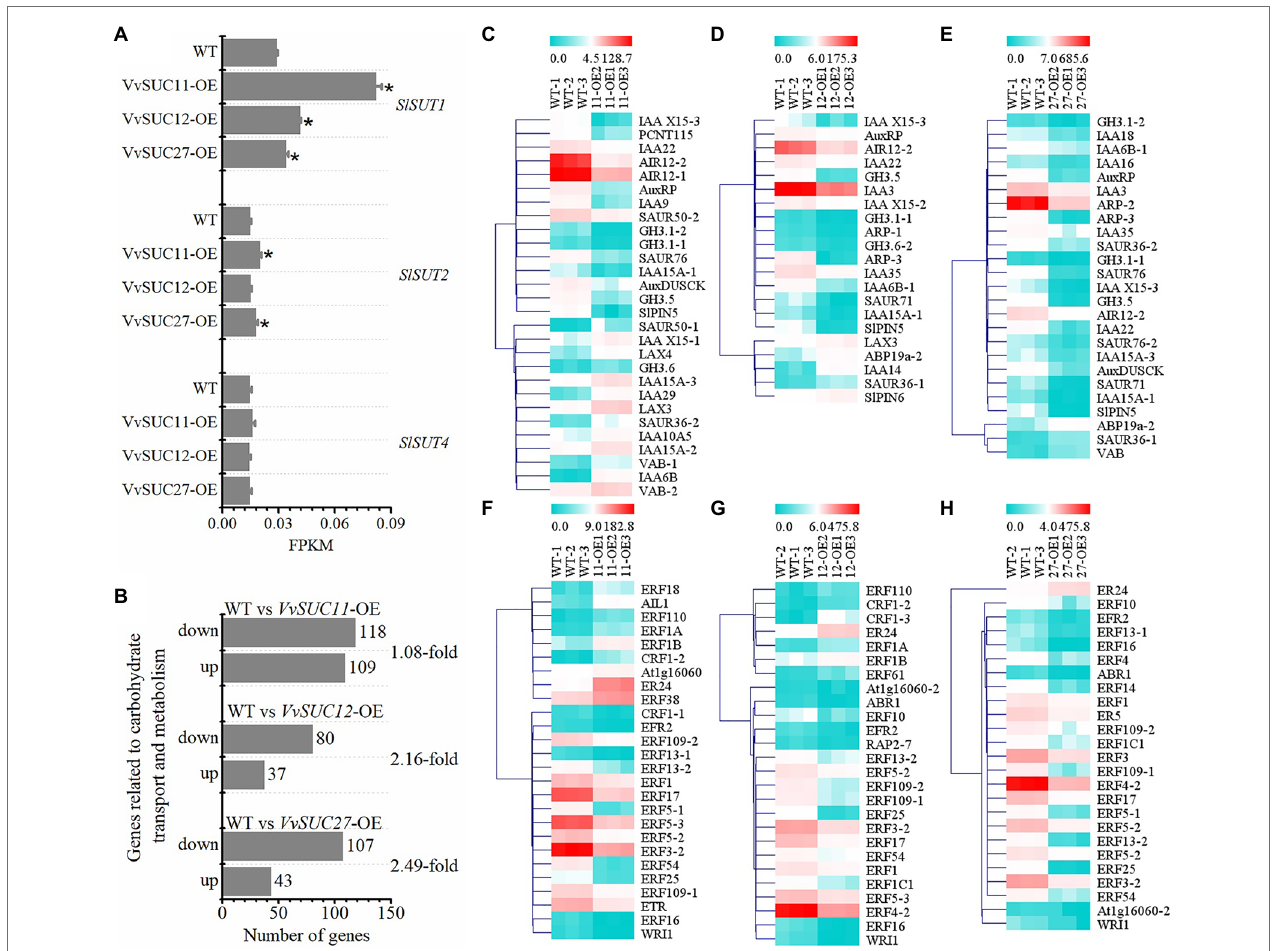
FIGURE 7 | Identification of genes related to SlSUTs , carbohydrate transport and metabolism, auxin and ethylene biosynthesis, and signaling. log2FC is short for log 2FoldChange . (A) Comparison between the WT and each VvSUC -OE line regarding FPKM of SlSUT1 , SlSUT2 , and SlSUT4 . (B) Number of upregulated and downregulated genes related to carbohydrate transport and metabolism pathway. (C–E) Heat map of genes related to auxin biosynthesis and signaling between the WT and each VvSUC -OE fruit. IAA, SAUR, or PCNT115, auxin-induced protein or auxin-responsive protein; GH, indole-3-acetic acid-amido synthetase; AIR, auxin- induced in root culture protein; ARP, auxin-repressed 12.5 kDa protein-like; AuxRP, auxin-regulated protein; SlPIN, auxin efflux facilitator; VAB, auxin canalization; ABP, auxin-binding protein; AuxDUSCK, auxin-regulated dual-specificity cytosolic kinase; LAX, auxin influx carrier (AUX1 LAX family). (F–H) Heat map of genes related to ethylene biosynthesis and signaling between WT and each VvSUC -OE fruit. Abbreviations: AIL1 or At1g16060, AP2-like ethylene-responsive transcription factor; CRF, WRI1, ABR1, RAP2, or ERF, ethylene-responsive transcription factor; ER, ethylene-responsive transcriptional coactivator; ETR, ethylene-binding protein. Statistically significant differences ( p < 0.05) are indicated by